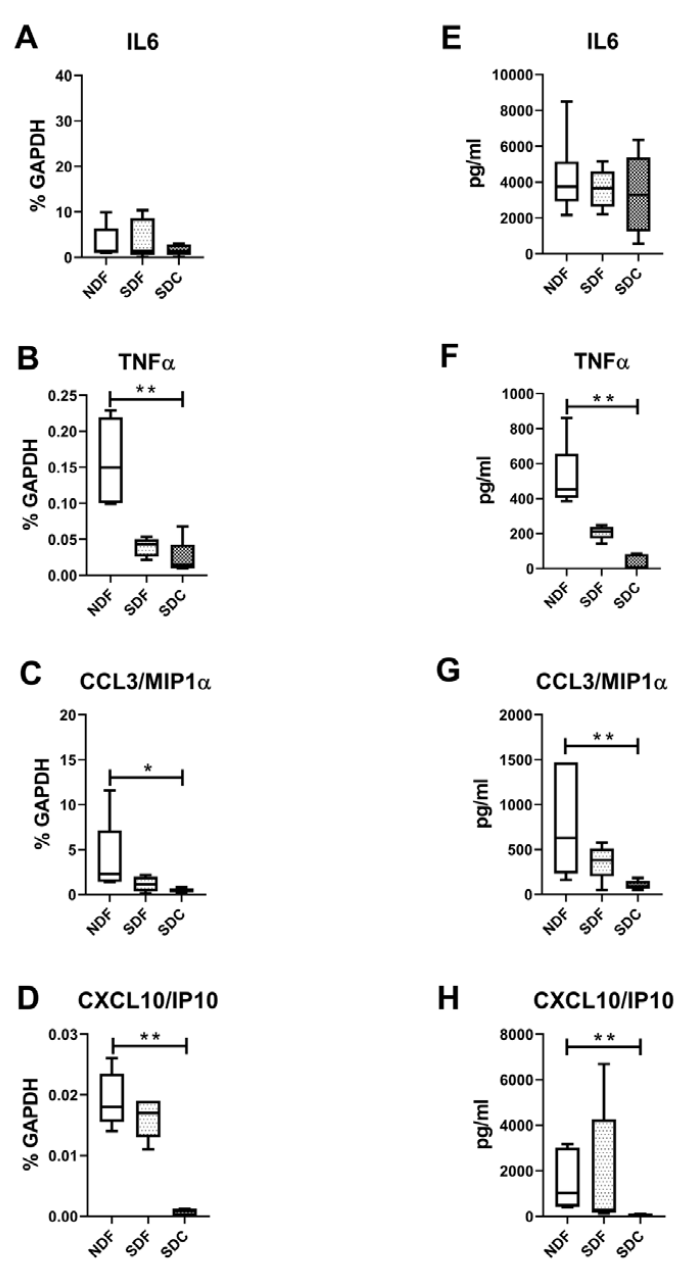
Figure 5. Evaluation of cytokines typical of synovial M1-like macrophages. IL6 ( A – E ), TNF α ( B – F